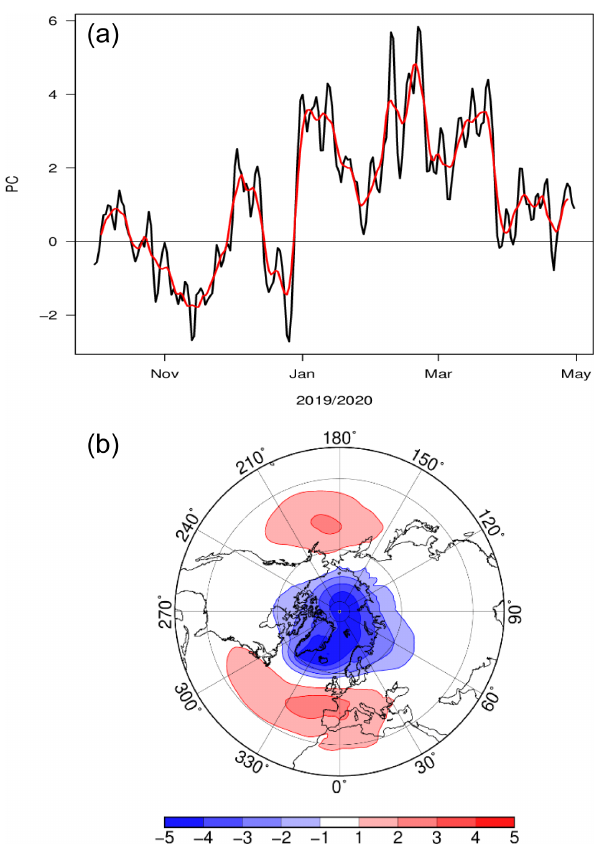
Figure 1. (a) Time series of daily values of the AO index from Oc- tober 2019 to April 2020 (black line) with the 7d running mean (red line) and (b) the spatial AO pattern from 1979 to 2000 based on